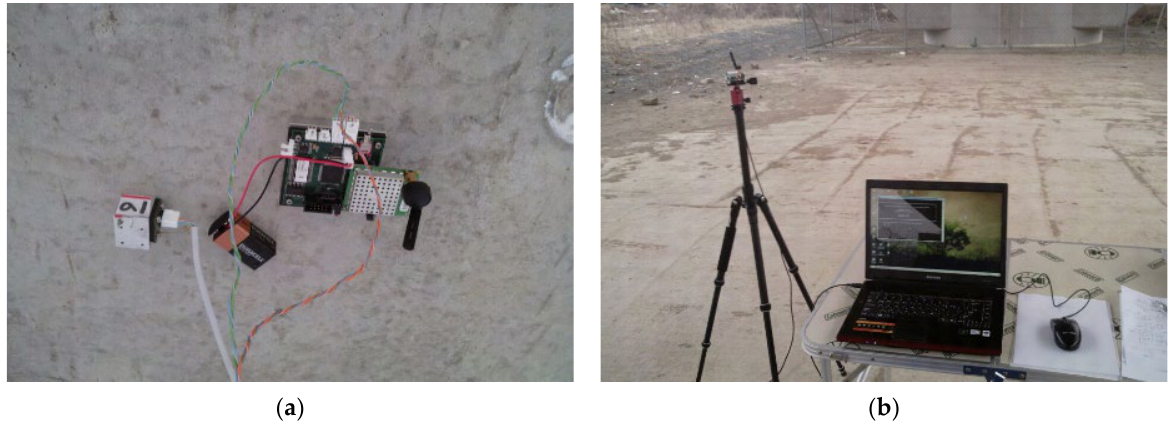
Figure 2. Wireless measurement system: ( a ) NARADA WSU and accelerometer; ( b ) Base station and laptop.